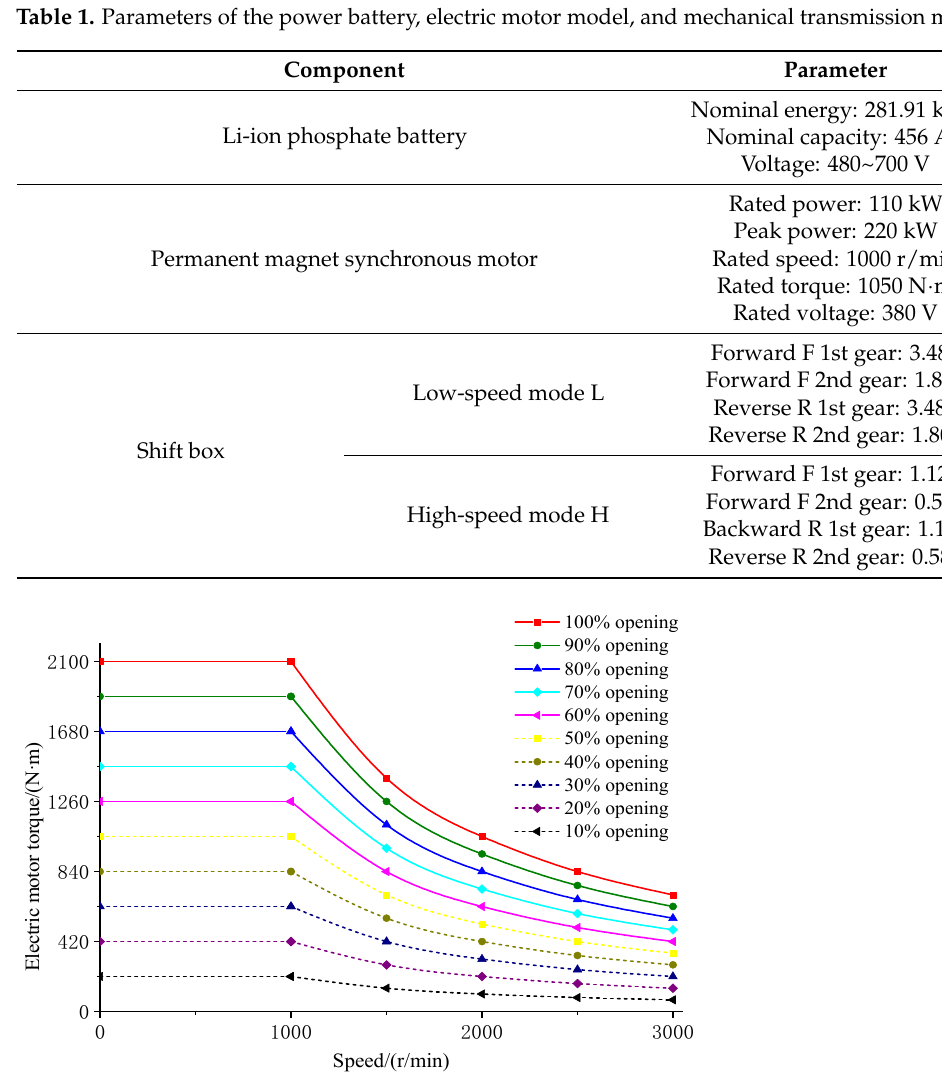
Figure 3. Speed torque curve of the 10%, 20%, ..., 100% accelerator pedal opening of an electric motor. Table 1. Parameters of the power battery, electric motor model, and mechanical transmission model.